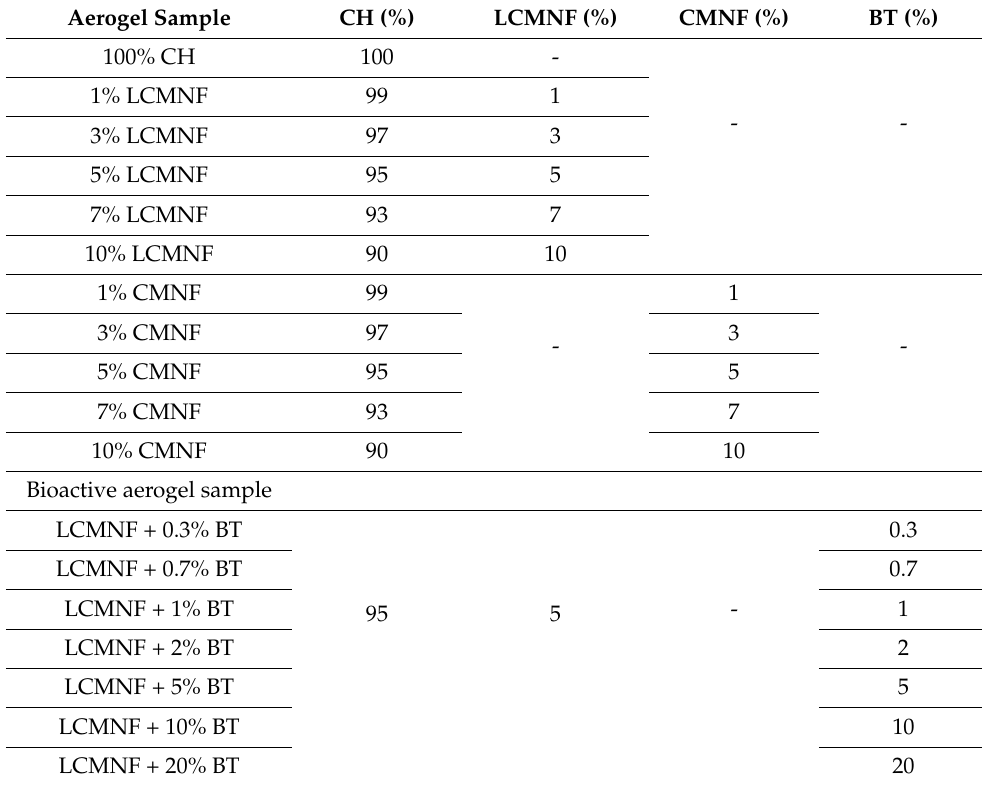
Table 1. Formulated (bioactive) aerogels